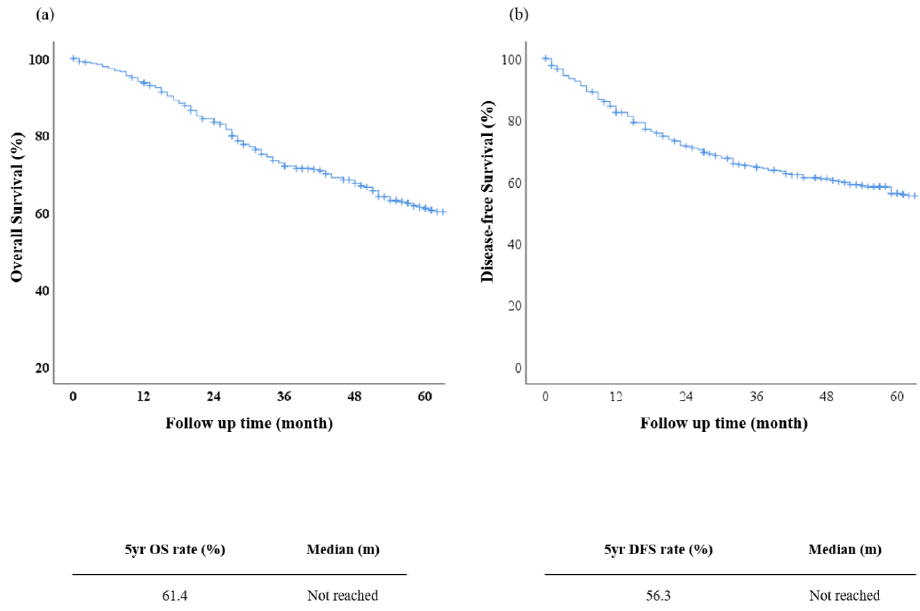
Figure 2. Survival outcomes: ( a ) overall survival; ( b ) disease-free survival. 5-year OS rate; 5-year overall survival rate, 5-year DFS rate; and 5-year disease-free survival rate.